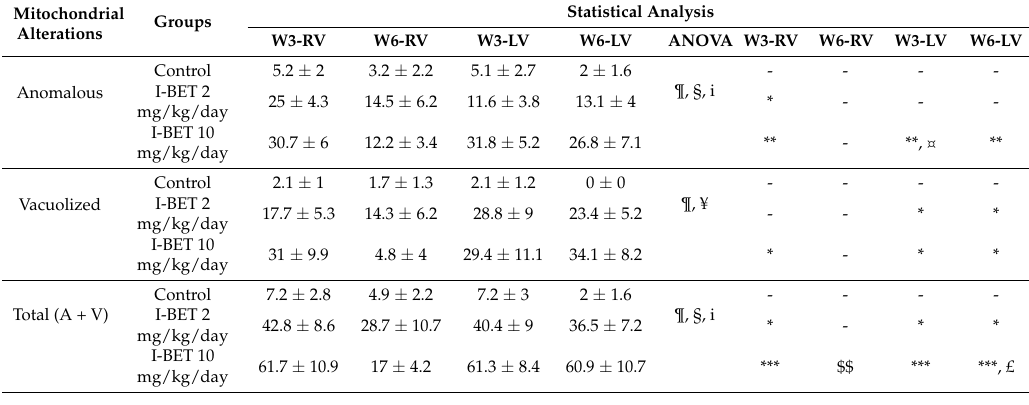
Table 1. Proportion of altered mitochondria amongst total mitochondrial population. Altered mitochondria were mitochondria with anomalies (A) or vacuoles (V). The sum of mitochondria with anomalies and mitochondria with vacuoles represents the totality of altered mitochondria (Total). Statistical analysis: multifactorial ANOVA. ¶— p ≤ 0.05 for the dose effect; §— p ≤ 0.05 for the washout effect; ¥— p ≤ 0.05 for the ventricle effect; i— p ≤ 0.05 for the interaction effect. Post hoc Newman–Keuls test: * p ≤ 0.05, ** p ≤ 0.01, *** p ≤ 0.001 for difference versus the control group (at a given time and for a given ventricle), ¤— p ≤ 0.05 for difference between IBET 2 mg/kg/day and IBET 10 mg/kg/day (at a given time and for a given ventricle), $$— p ≤ 0.01 for difference between W3 and W6 (for a given dose and a given ventricle), £— p ≤ 0.05 for difference between right ventricle and left ventricle (at a given time).